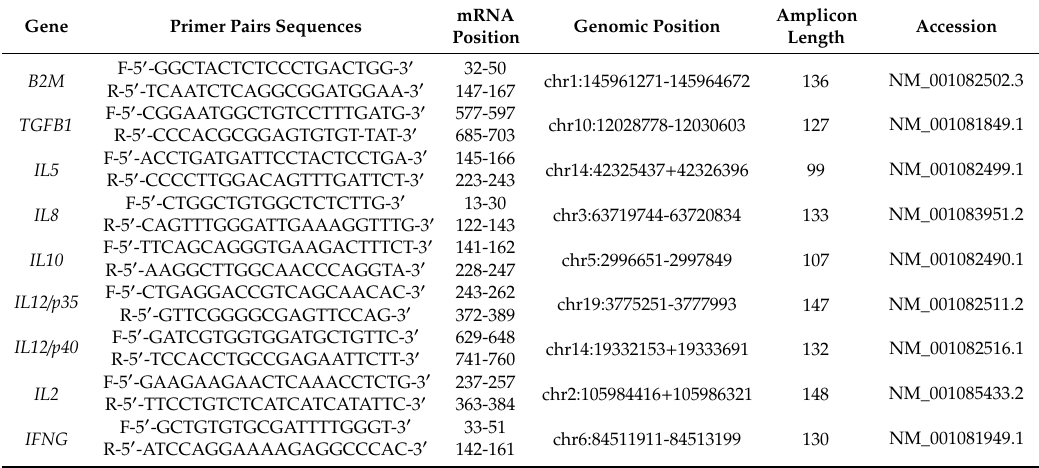
Table 3. Primers set used in this study to evaluate cytokines genes